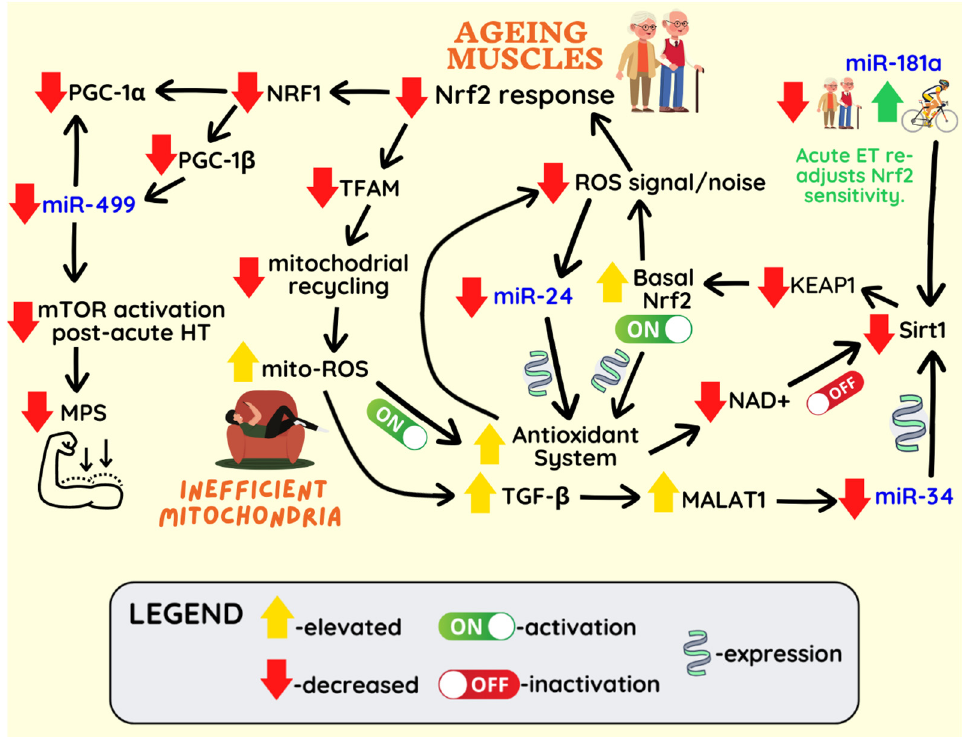
Figure 2. Chronic baseline ROS overload prompts miRNA-mediated pro-reductive shift, and consequent decline in redox and hypertrophic sensitivity. Nrf2 activation in response to endurance training (ET) declines in ageing muscles. This results in decreased PGC-1 β , which regulates the expression of miR-499. Downregulation of miR-499 correlates with reduced mTOR phosphorylation in response to hypertrophy training (HT) in older individuals, potentially contributing to reduced muscle protein synthesis (MPS). Mitochondrial ROS production increases in older individuals or metabolically inefficient mitochondria in younger individuals. Increased ROS induces TGF- β 1/MALAT1/miR-34 cascade leading to decreased Sirt1 expression. Elevated ROS levels stimulate the antioxidant systems, resulting in NAD + consumption. Decreased NAD + levels contribute to lower Sirt1 activation. Decreased Sirt1 deacetylase activity results in KEAP1 (negative Nrf2 regulator) downregulation. Consequently, Nrf2 nuclear translocation increases at rest, resulting in the induction of antioxidant genes (SOD2 and catalase). Hyperactivity of the antioxidant system masks the ROS bursts induced by exercise, inhibiting the expression of the ROS-induced miR-24, which normally suppresses key antioxidants (SOD1 and PRDX6). miR-181a, targeting Sirt1 is elevated in old muscles potentially to compensate for decreased Sirt1 expression. Contrastingly, miR-181a is elevated in response to a single bout (but not long-term) of high-intensity ET, possibly re-adjusting the Nrf2 breakdown rate and therefore elevating redox sensitivity via the Sirt1/KEAP1 pathway.